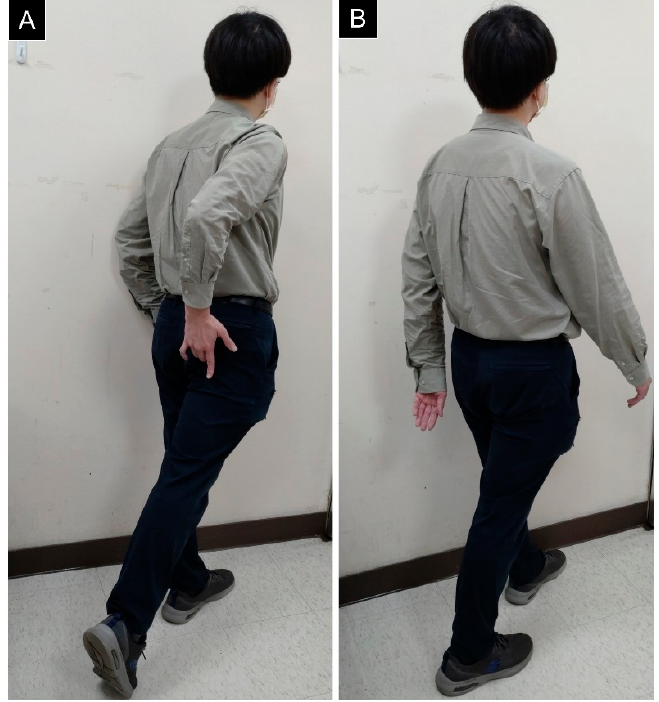
Figure 4. Pain over the ischium can be reproduced by walking with a long stride ( A ) and relieved during short-stride walking ( B ).